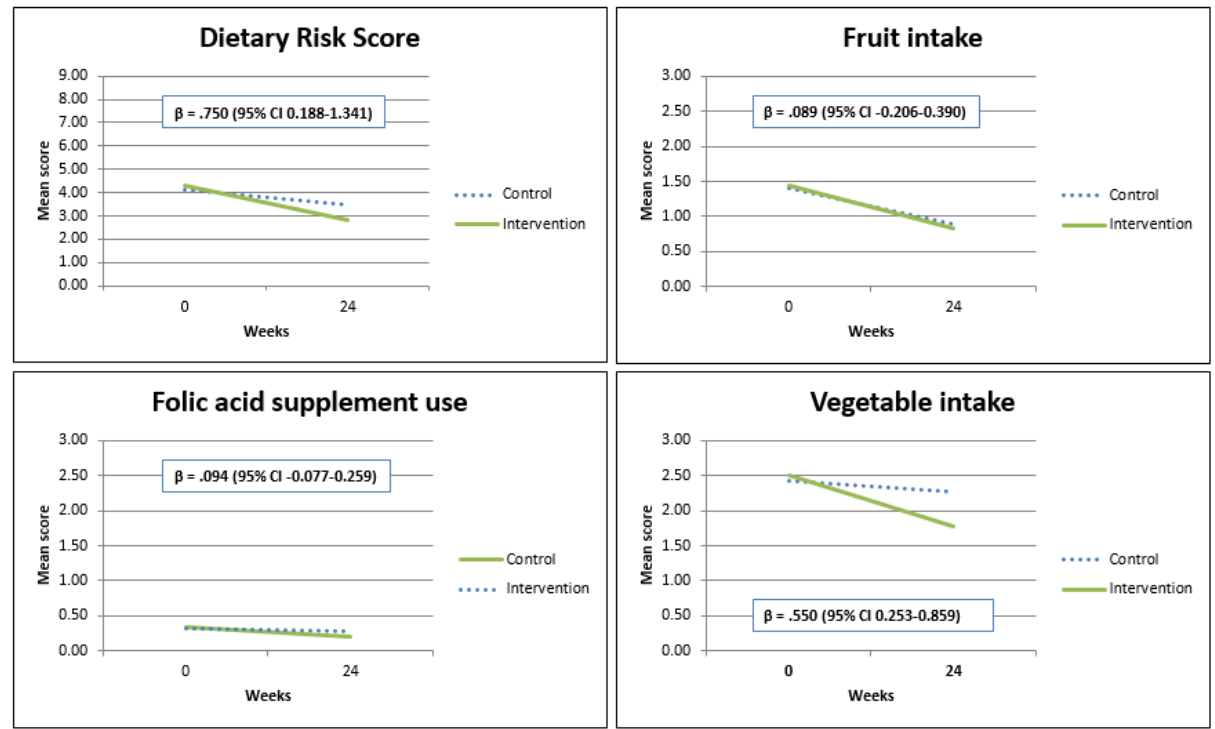
Figure 2. Dietary risk score (DRS) and separate risk factors over time in all women (with a baseline DRS>0) in the intervention and control groups. The linear regression model includes adjustment for baseline DRS and